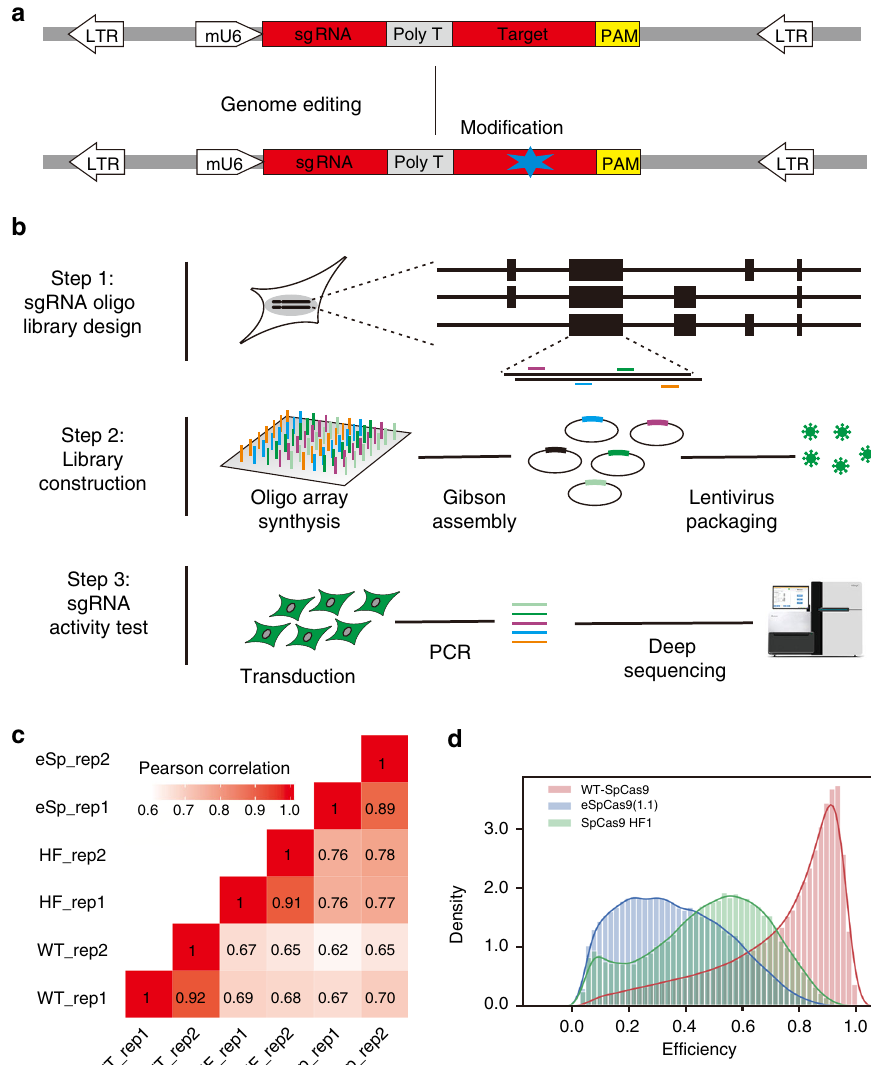
Fig. 2 A guide RNA – target pair strategy for high-throughput screen of gRNA activity in human cells. a Schematic diagram of the guide RNA – target pair strategy for gRNA activity test. A lentiviral vector contains a mU6 promoter, and a guide RNA – target pair. The vector was used to transduce cells expressing Cas9 nucleases. Indels would be induced at integrated targets by the corresponding gRNAs. b Schematic diagram of design and high- throughput screen of a gRNA library. A library of 80,263 guide RNA – target pairs was designed and synthesized by microarray. Oligonucleotides were PCR- ampli fi ed and cloned into lentiviral vectors by Gibson assembly. The library was packed into viruses and transduced into cells expressing Cas9 nucleases for genome editing. The integrated target sites were PCR-ampli fi ed for deep-sequencing analysis. c The Pearson correlation of indel frequency among different experiment repeats. d The distribution of gRNA activity for the three Cas9